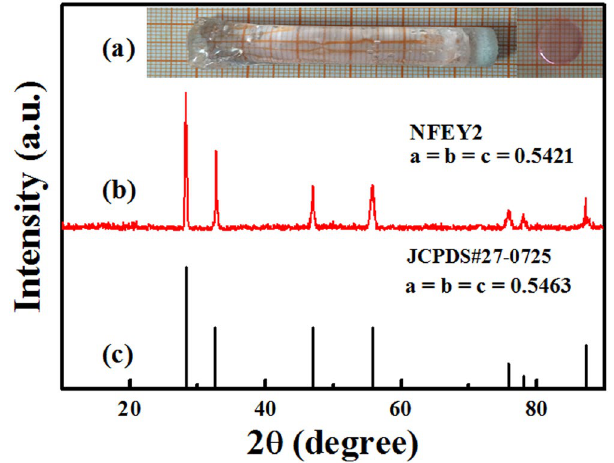
Figure 1. ( a ) The photo of Na 5 Lu 9 F 32 single crystal, the left is boule of the crystal and the right is polished slice. ( b ) XRD patterns of the Na 5 Lu 9 F 32 : Er 3 + /Yb 3 + . ( c ) Standard line patterns of Na 5 Lu 9 F 32